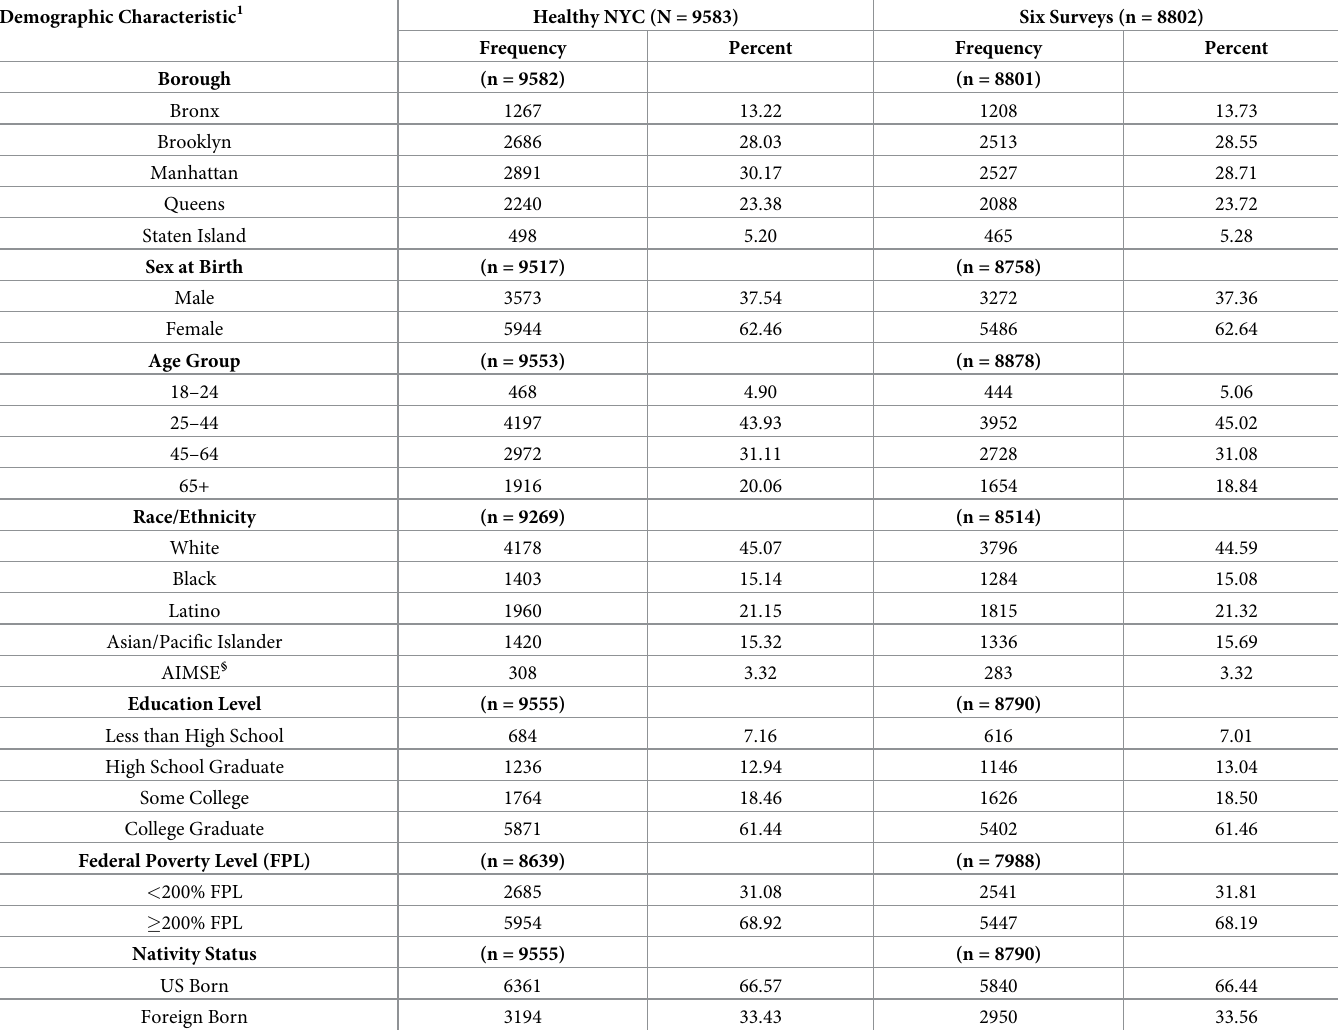
Table 1. Sociodemographic characteristics of Healthy NYC panelists as of June 2021 vs. sampled panelists among the six surveys. Demographic Characteristic